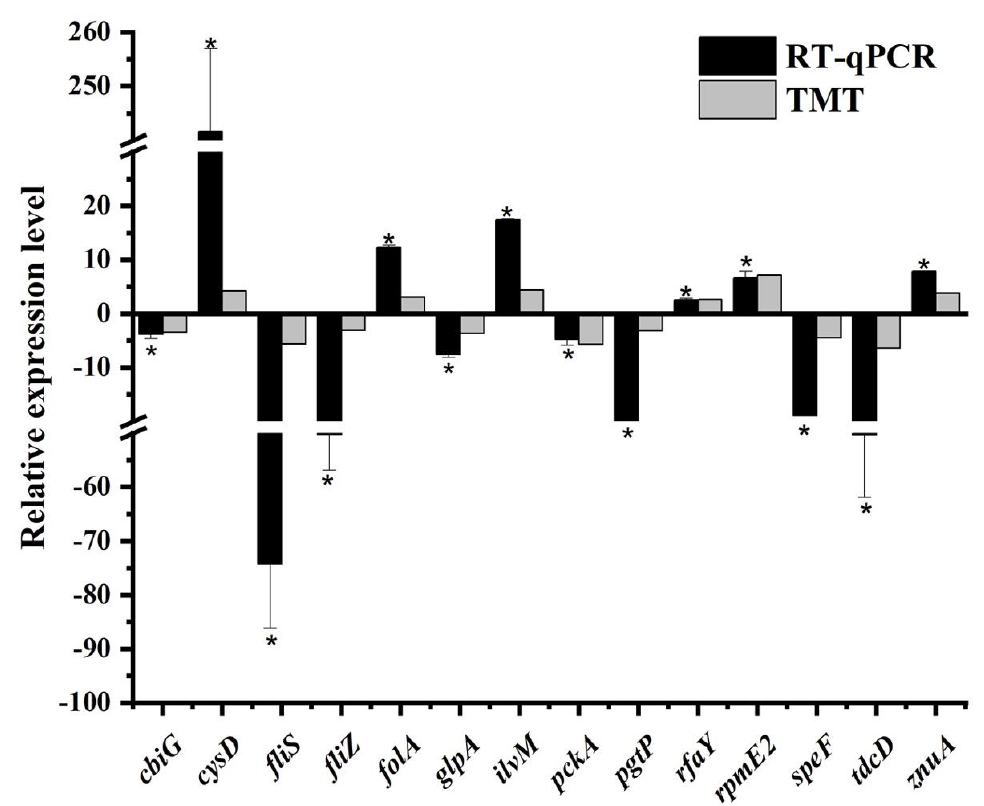
Figure 3. Comparison between protein abundance patterns and gene expression profiles in S . Enteritidis in response to 130 ppm sodium hypochlorite. Asterisk indicates a significant difference ( p < 0.05).